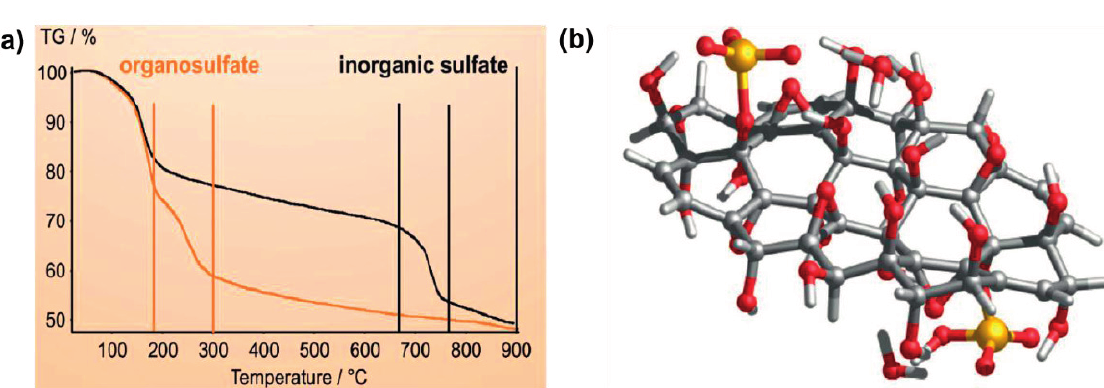
Figure 3. ( a ) The TGA data of GO-NaHSO 4 revealing two main decomposition steps for sulfur-containing species. ( b ) The proposed structural model of GO terminated with epoxy, hydroxyl, and organosulfate as dominant functional groups. Reproduced with permission from [57]. Copyright (2013) Wiley-VCH Verlag GmbH &